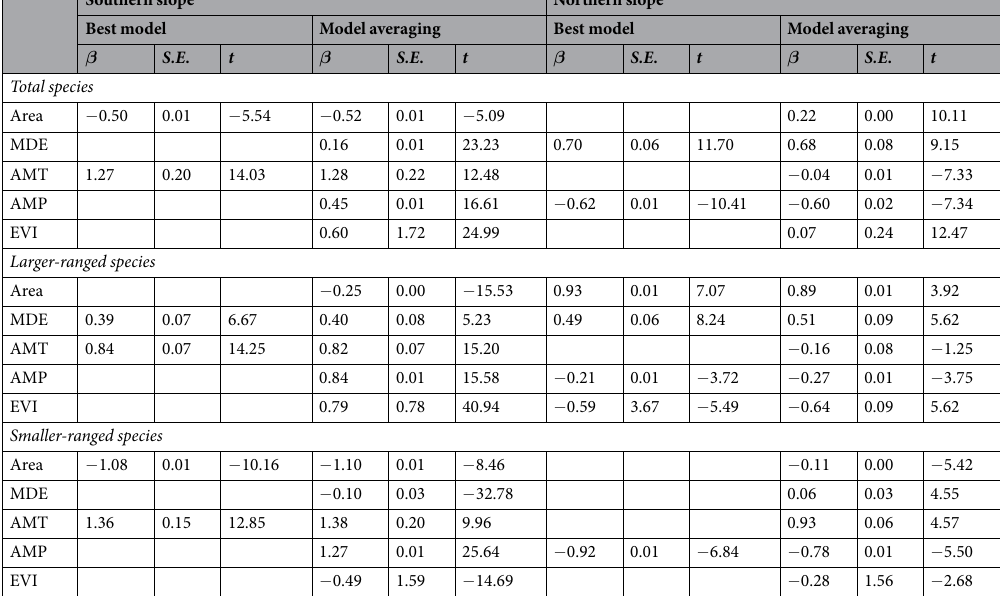
Table 1. Multiple ordinary least squares regressions on species richness against five explanatory factors for different species groups on the southern and northern slopes of Mt. Taibai, China. Only the results of the best model and the model averaging for each gradient are presented, and the model selection is based on the lowest Akaike Information Criterion (AIC c ) values. Larger-ranged species: the 50% of species with ranges above the median range size; smaller-ranged species: the 50% of species with ranges below the median range size.